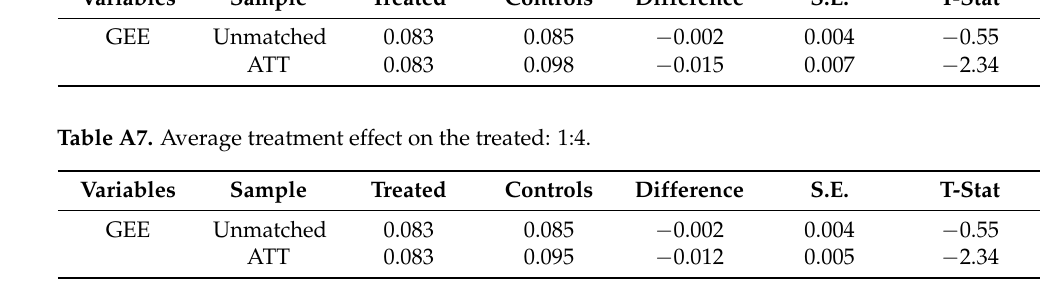
Table A6. Average treatment effect on the treated: 1:1. Variables